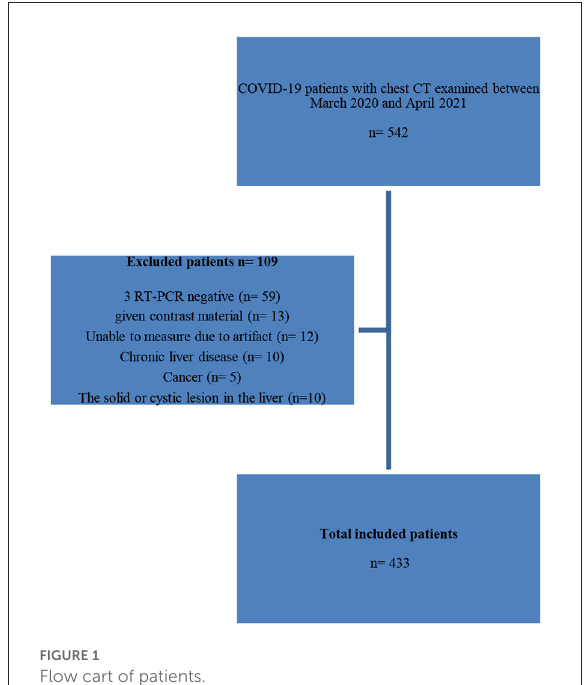
FIGURE1 Flow cart of